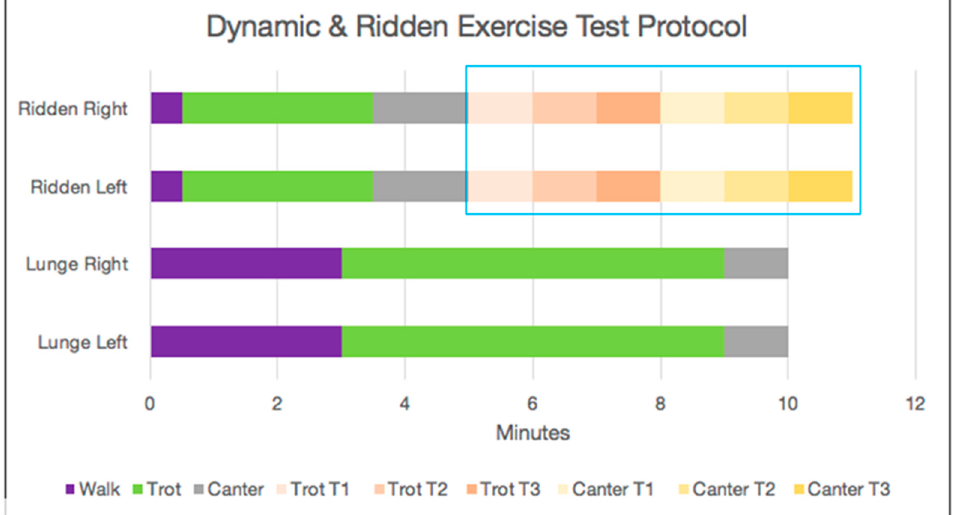
Figure 1. Illustrating the time spent on each rein and gait for both the dynamic unridden exercise test and ridden exercise test. The blue box represents the time when saddle pressure data were collected for trial 1 (T1), T2 and T3 on both the left and right rein in trot and canter.